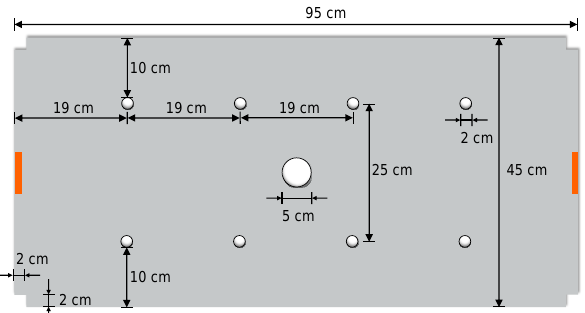
Figure 3. Hole cover plate.